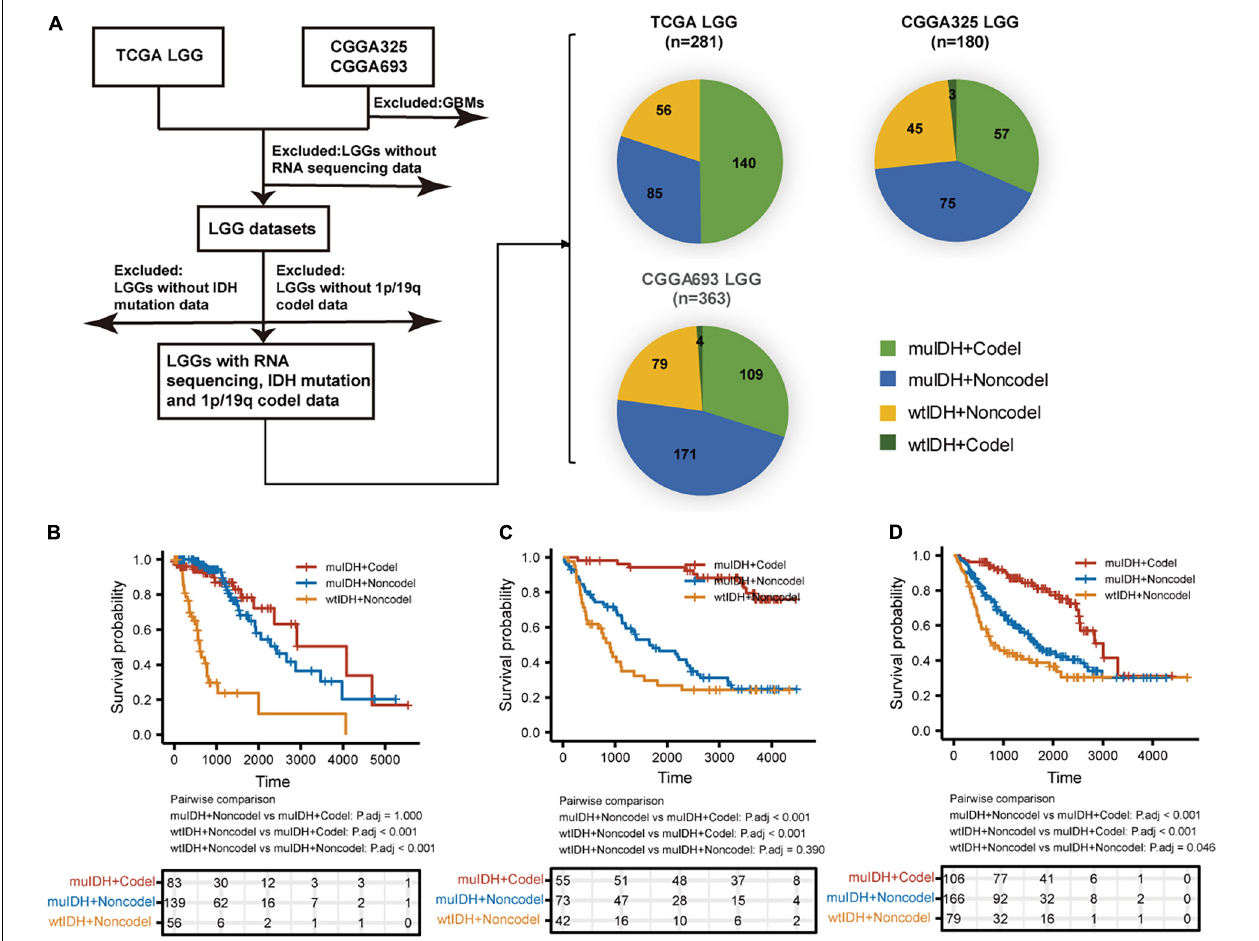
FIGURE 1 | Sample and data collection in this study. (A) Only LGGs with RNA-sequencing data, IDH mutation, and 1p19q codel status information in TCGA and CGGA datasets were included in this study. (B–D) Kaplan–Meier analysis of OS (overall survival) of patients with LGGs according to IDH mutation and 1p/19q codel status in TCGA LGG (B) , CGGA325 LGG (C) , and CGGA693 LGG (D)